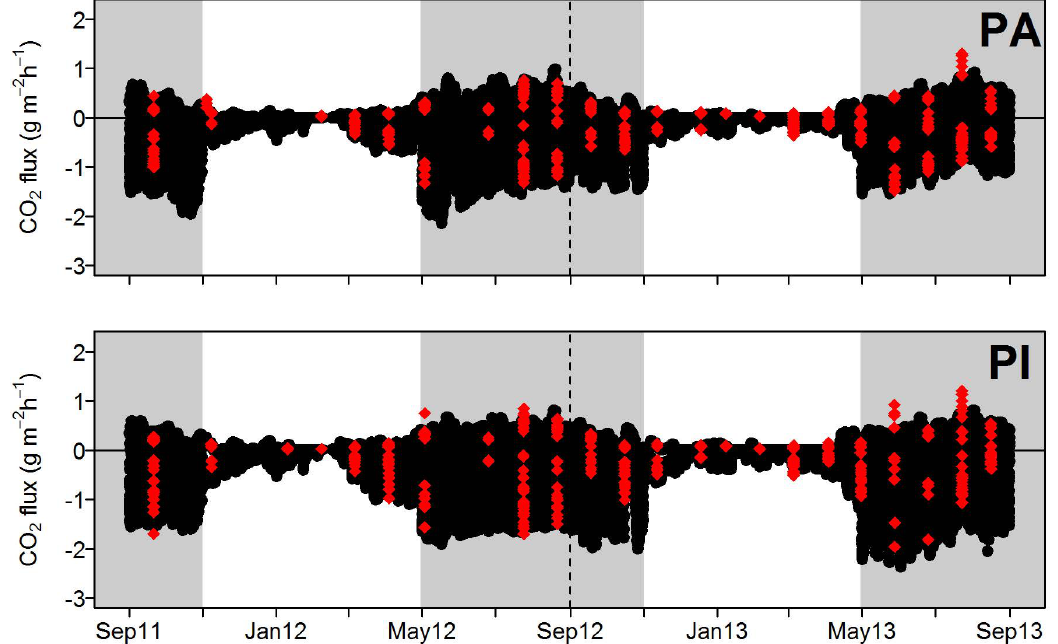
Figure 4. NEE fluxes (g m -2 h -1 ) of the two production strips with S . palustre (PA) and S. papillosum (PI) during the establishment phase. Modelled (black circles) and measured (red diamonds) values are given. The main growing seasons (May to October) are indicated by a grey background.